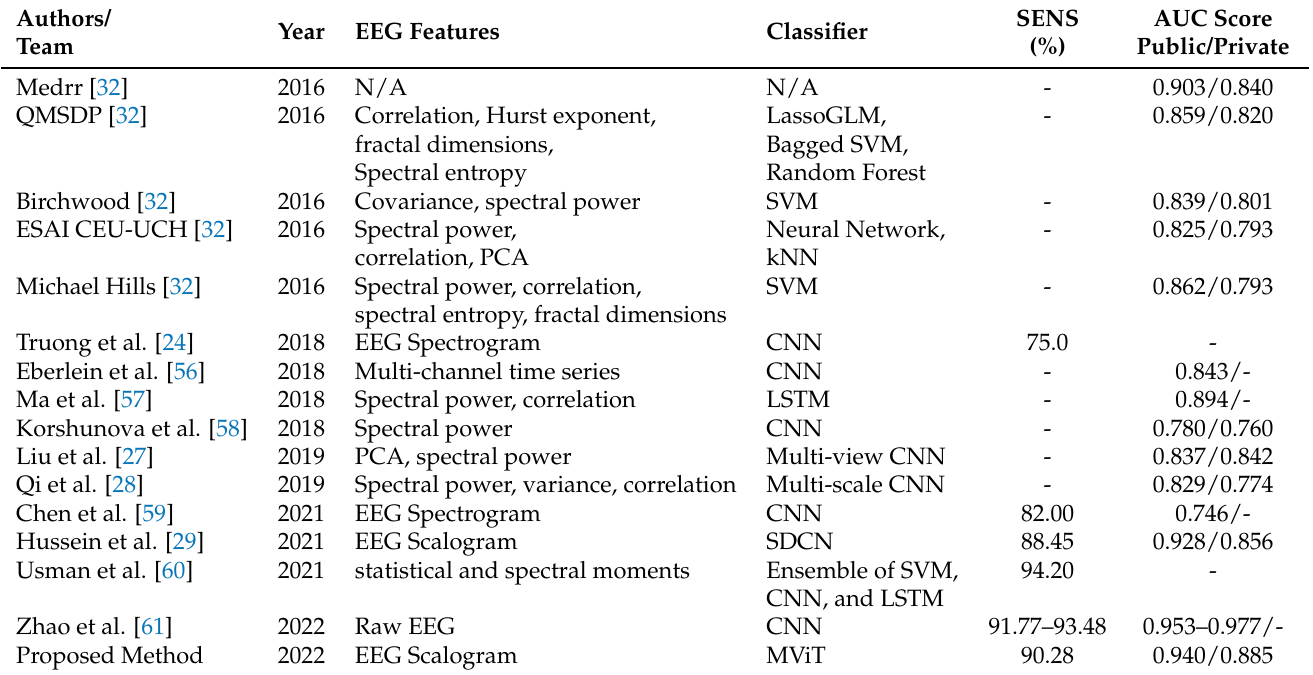
Table 2. Benchmarking of the previous seizure-prediction methods and our MViT approach: Kag- gle/AES Seizure Prediction